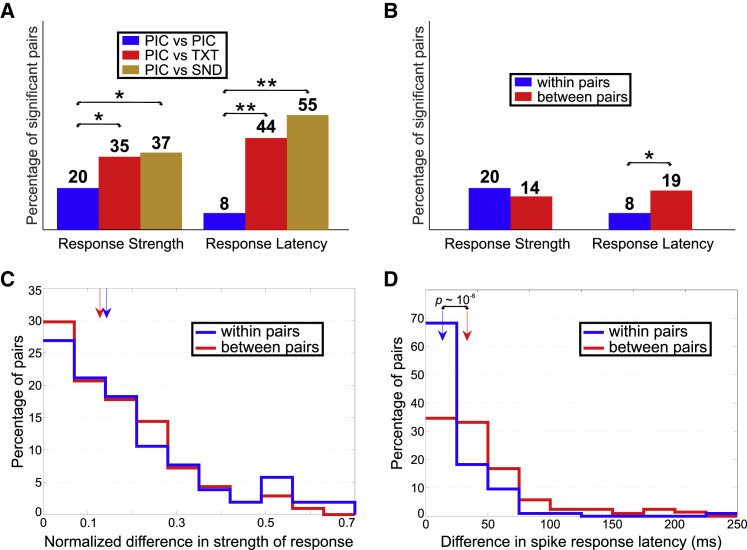
Comparison of Responses within and between Identities(A) Percentage of pairs exhibiting significant differences in strength (left) and latency (right) according to a permutation test for the response-eliciting pairs “within identity.” The pairs could be formed by two responsive pictures (PIC versus PIC), one responsive picture and the written name from the same identity (PIC versus TXT), or one responsive picture and the spoken name from the same identity (PIC versus SND). The percentage was significantly smaller for the PIC versus PIC case when compared with the others. ∗p < 0.05; ∗∗p < 10−6. An alternative analysis was performed using a decoding approach. Figure S4 shows an example of a decoder being unable to significantly distinguish among the stimuli within a given identity.(B) Proportion of pairs exhibiting significant differences in strength (left) and latency (right) according to a permutation test for the response-eliciting pairs “within identity” (from the current dataset) and “between identities” (from the dataset reported in [26], see STAR Methods). These proportions showed no significant differences across the datasets for strength (Z test, p = 0.15), but the proportion for the within identity dataset was significantly smaller than for the between identities dataset (Z test, p = 7.3 × 10−3).(C) Distributions of the normalized difference in strength of response for each dataset. Vertical arrows denote the median of the corresponding distributions. There was no significant difference between them (rank-sum test, p = 0.12).(D) Same as in (C) but for differences in latency. We observed that the latency difference was significantly smaller for within identity pairs than for between identities pairs (rank-sum test, p ∼10−8).